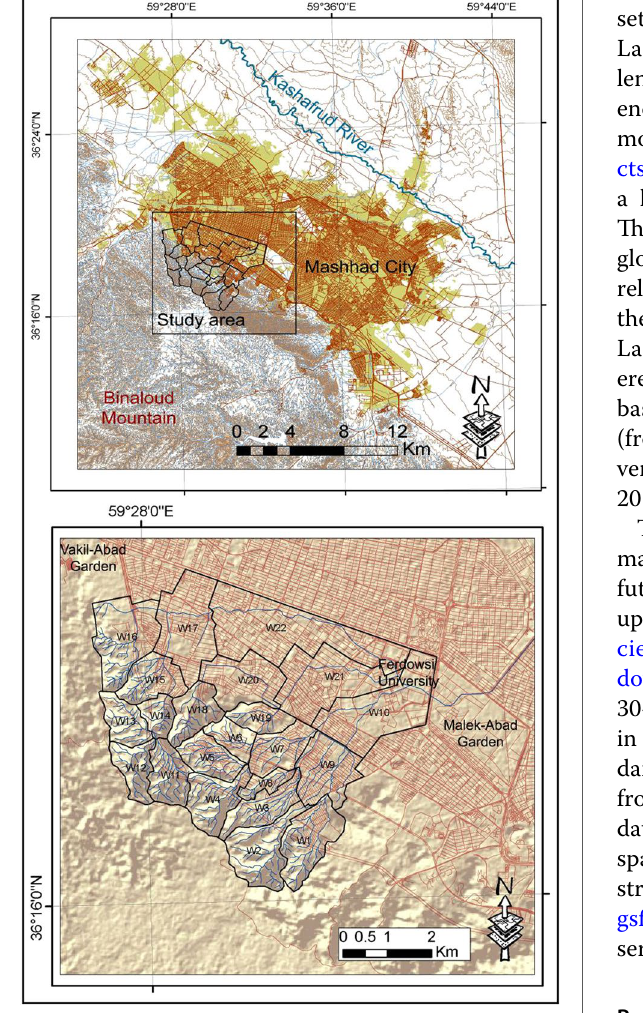
Fig. 1 Geographical location of the study